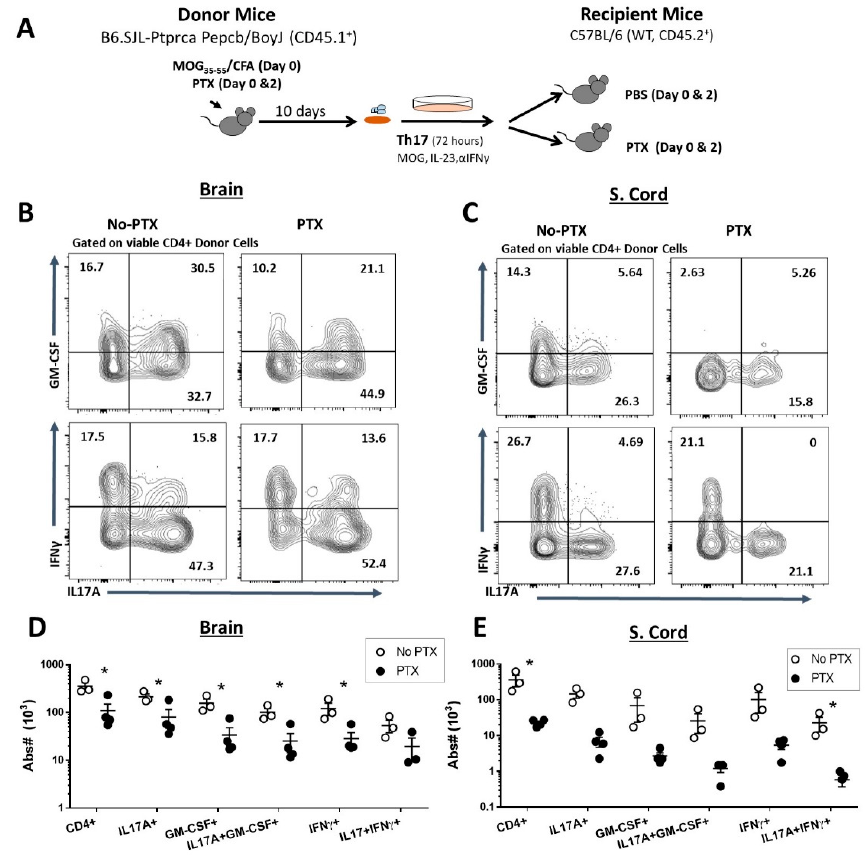
Figure 2. Pertussis toxin reduced accumulation of encephalitogenic CD4 + T cells in the CNS. ( A ) Th17-EAE was induced in wild-type CD45.2 + mice with Th17 cells derived from CD45.1 + donor mice and treated with PTX (250 ng IP) or PBS (No PTX) on day 0 and 2 post-transfer. Representative flow cytometry plots of IL17A + GM-CSF + and IL17+IFN γ expressing CD4 + donor T cells in the ( B ) brain and ( C ) spinal cord of mice with Th17-EAE treated with or without PTX. Gated on viable CD4 + CD45.1 + population in the brain and spinal cords of mice with Th17-EAE. Absolute number of IL17A + , GM-CSF + , IFN γ + , IL17A + GM-CSF + and IL17A + IFN γ + CD4 + CD45.1 + donor T cells in the ( D ) brain and ( E ) spinal cord of mice with Th17-EAE treated with (PTX) or PBS (No PTX); n = 3–4/group. Statistical analysis was performed using Student’s t- test (* p < 0.05).